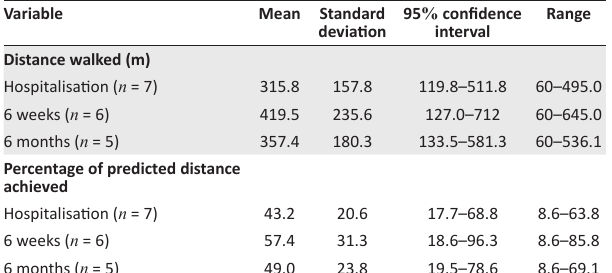
TABLE 4: Results for exercise endurance as measured with the six-minute walk test.